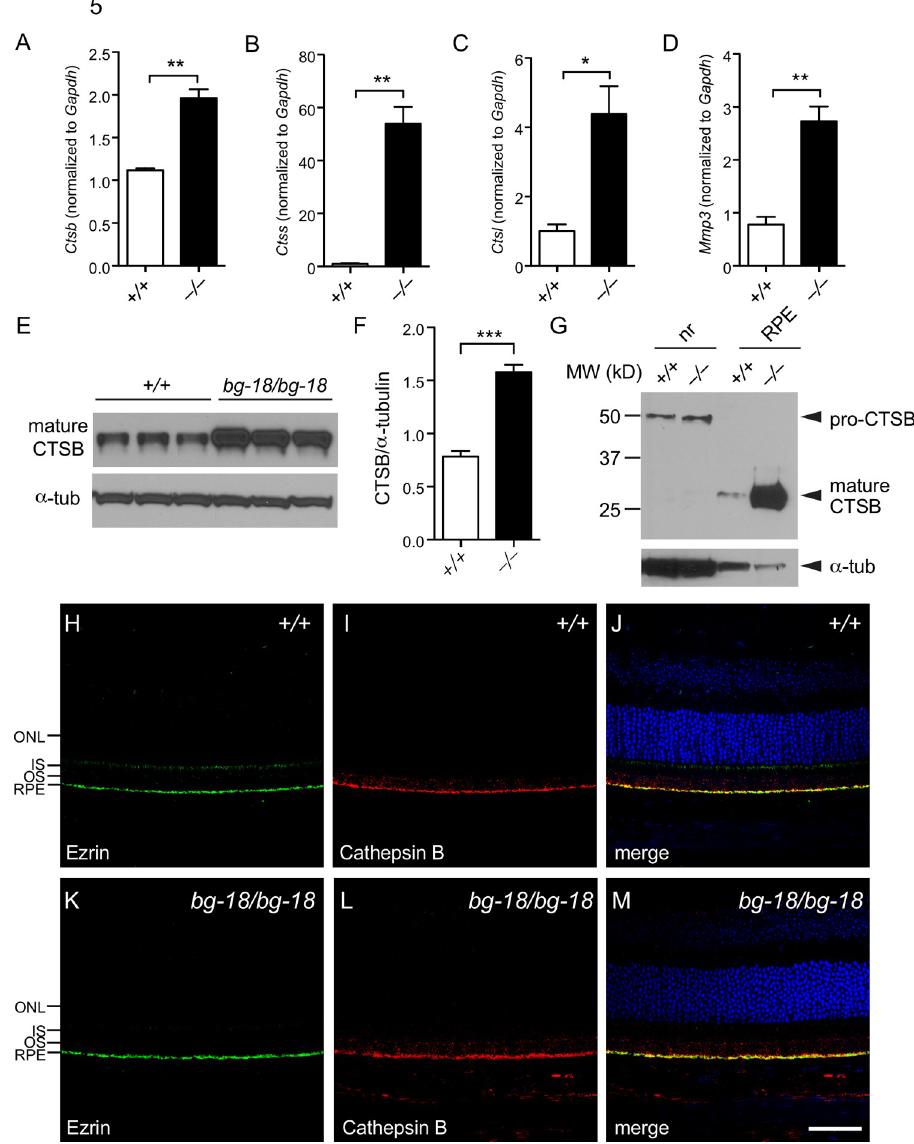
Fig 5. Elevation of cathepsins and MMP3 in the Lyst mutant RPE. (A-D) Quantitative RT-PCR results showing cathepsin B (A), cathepsin S (B), cathepsin L (C), and MMP3 (D) transcript levels in 3-week-old wild type (open bars) and mutant (filled bars) RPE. Three mice of each genotype and three technical replicates per mouse were used. Values are expressed as mean ± SD, � : P < 0.05; �� : P < 0.01 (two-tail unpaired t -test). (E-F) Cathepsin B (CTSB) protein level is also increased in 3-week-old mutant RPE shown by western blot analysis (E). The results are quantified (F). Three mice of each genotype were used. Values are expressed as mean ± SD, n = 3, ��� : P < 0.001 (two-tail unpaired t -test). G. In the retina, mature cathepsin B is mainly in the RPE, whereas the pro-cathepsin in the neuroretina is largely unprocessed. (H-M) Cathepsin B is localized to the apical surface of the RPE. Retinal sections from 4-week-old wild type (H-J) and mutant (K-M) were subjected to immunohistochemistry with antibodies against ezrin (H, K) and cathepsin (I, L). Merged images are shown (J, M). (n = 3 per cohort) Retinal layers are labeled to the left. ONL: Outer nuclear layer; IS: Inner segment; OS: Outer segment; RPE: Retina pigment epithelium. Scale bar = 50 μ m.